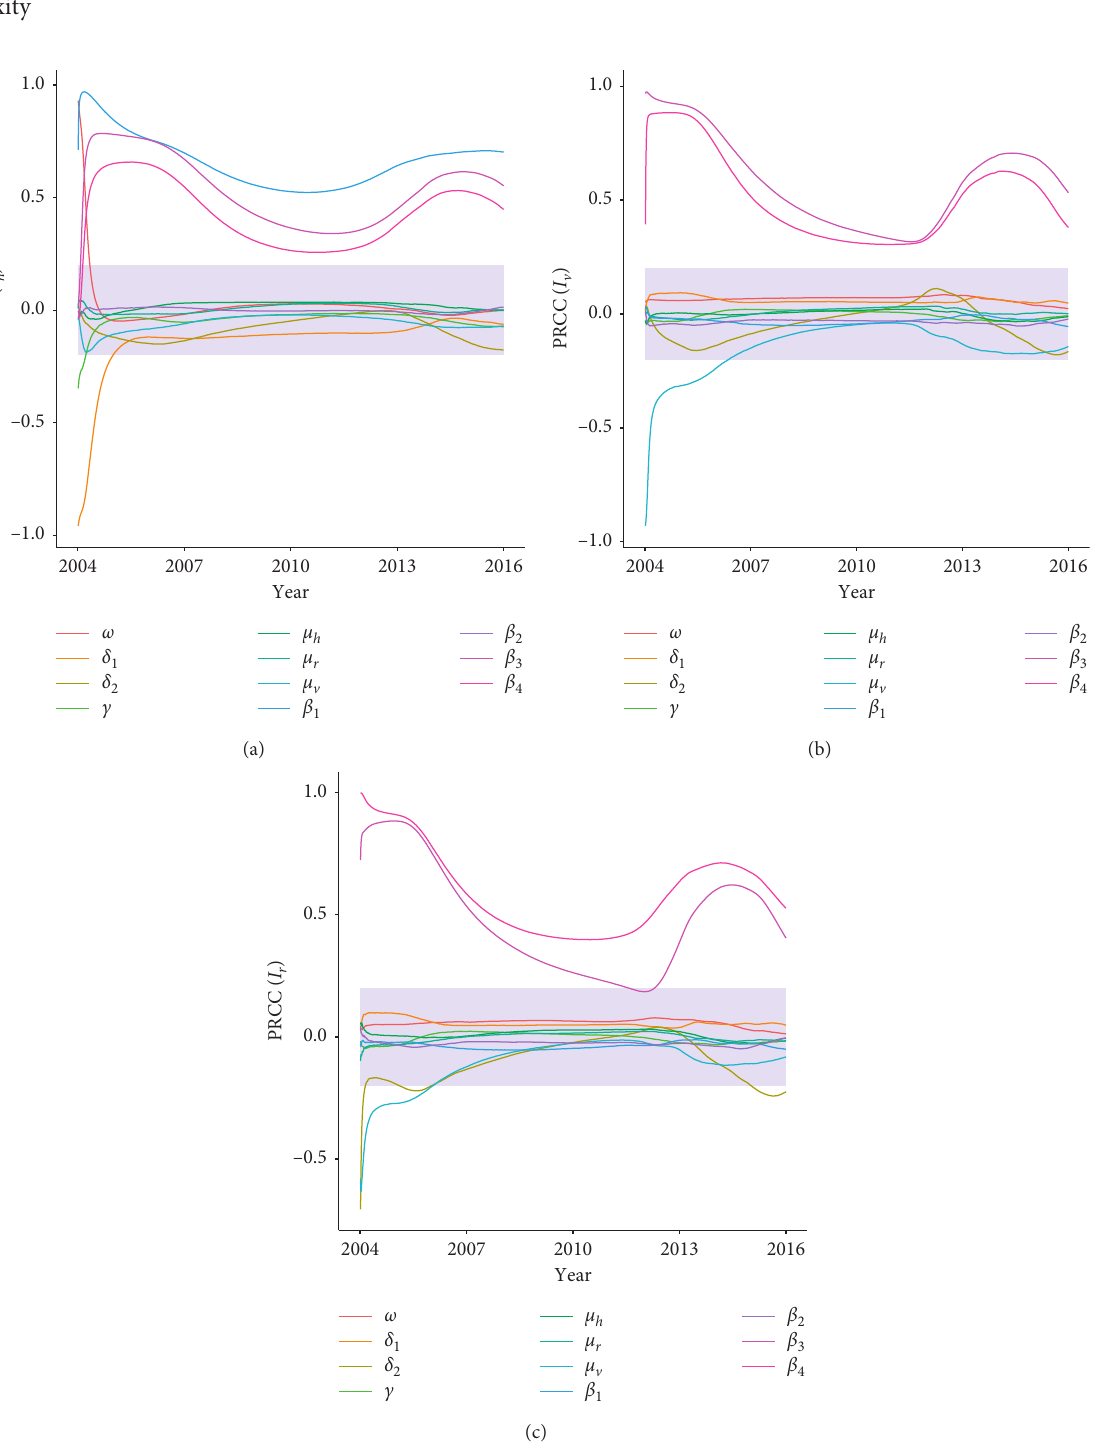
Figure 6: Sensitivity analysis: PRCC of the eleven parameters for (a) the number of infected humans, (b) the number of infected sandflies, and (c) the number of infected